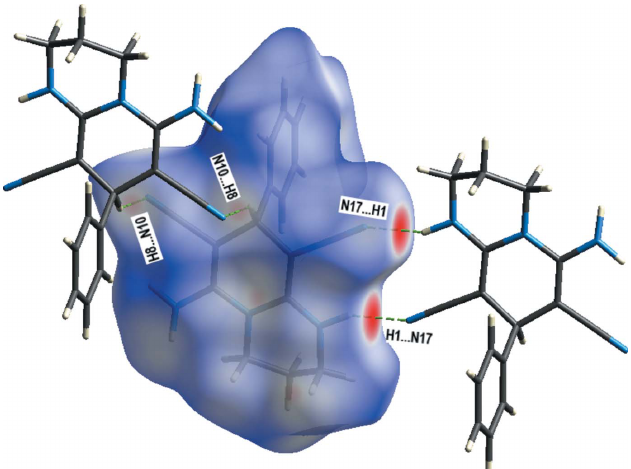
Figure 4 The three-dimensional Hirshfeld surface of the title compound plotted over d norm in the range (cid:5) 0.47 to +1.30 a.u.